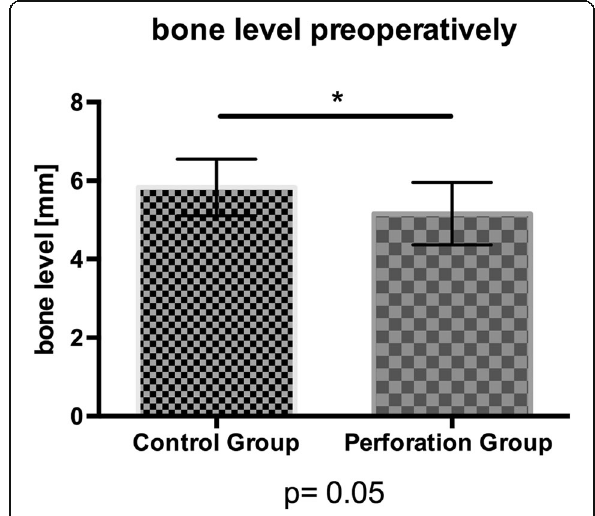
Fig. 4 The initial bone level of the control group and the perforation group